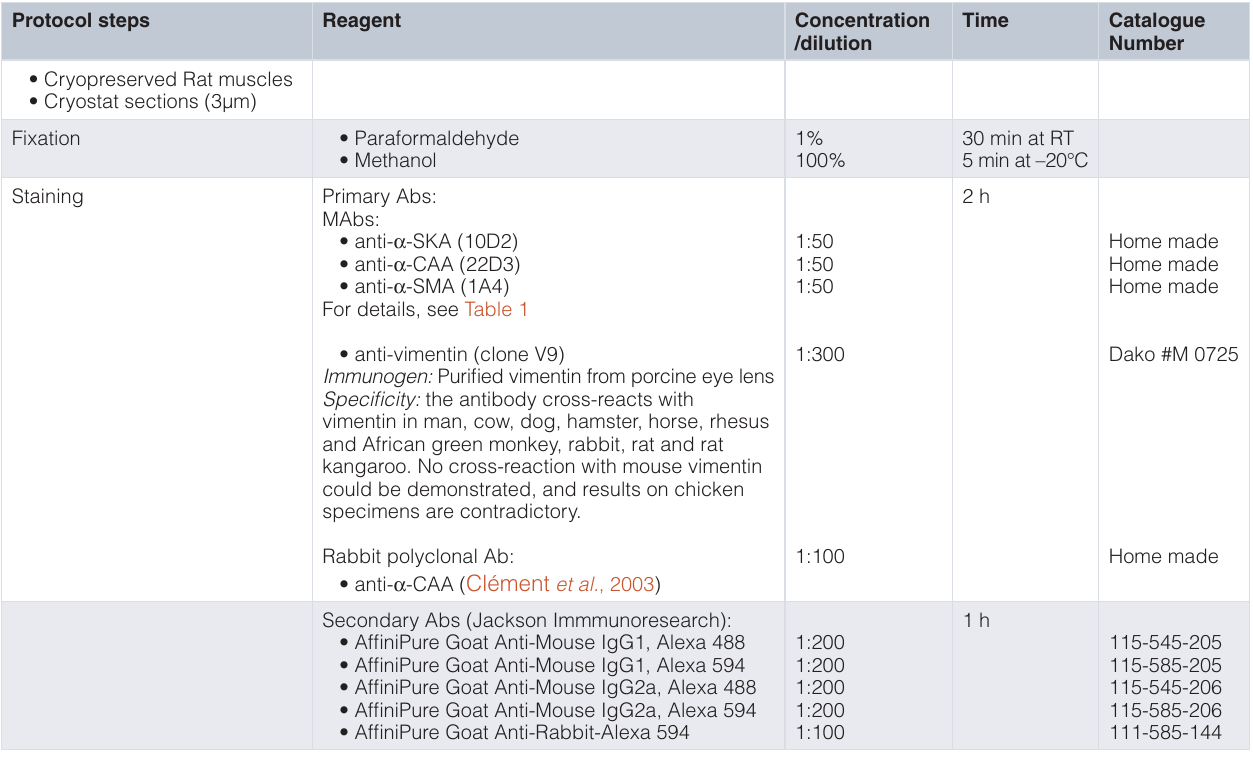
Table 3. Details of immunofluorescence staining protocol.